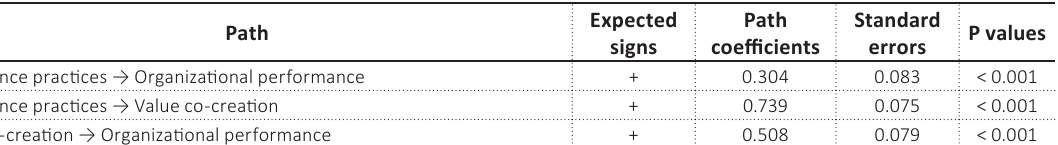
Table 5. Path analysis result